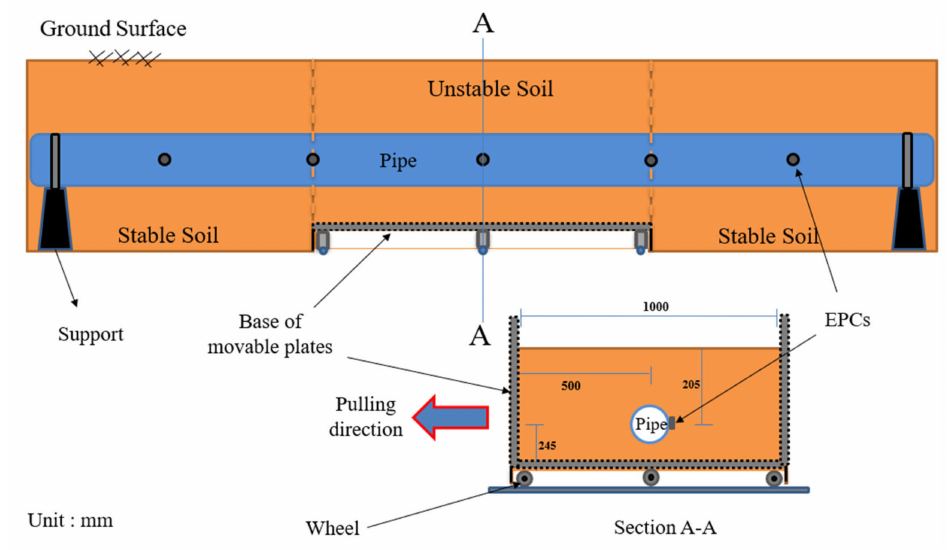
Figure 3. Cross-section of the physical model used to assess lateral pipeline–soil interaction in sandy soil.